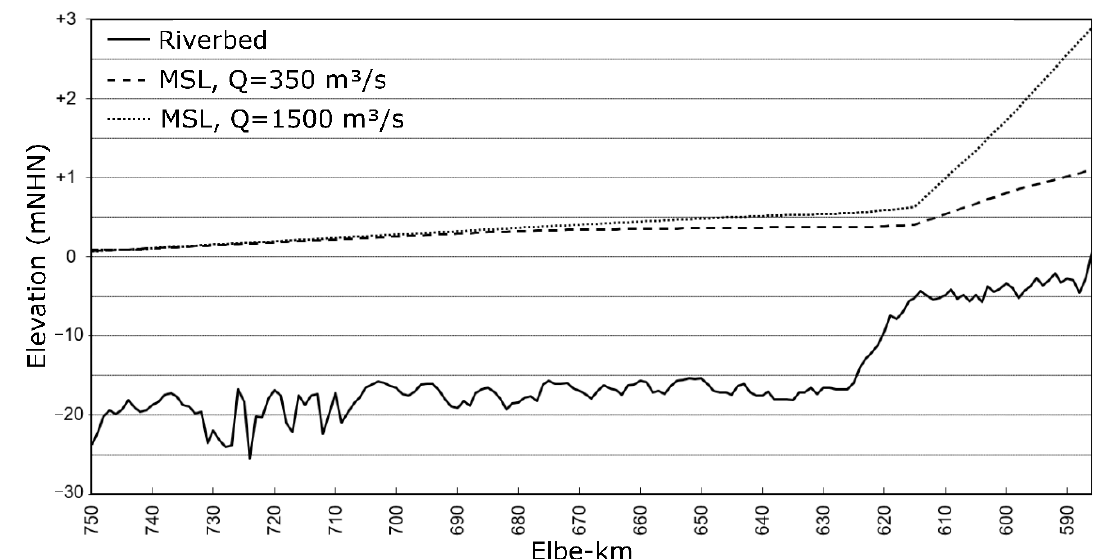
Figure 2. Fairway bathymetry averaged over 1 km representative for the investigation period, and mean sea level (MSL) for river discharges of 350 m 3 /s and 1500 m 3 /s.